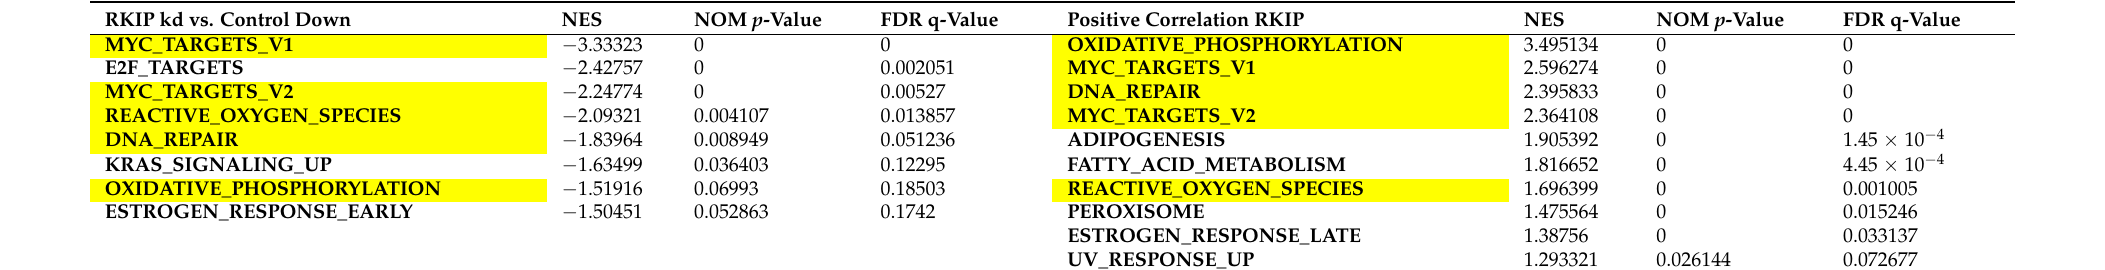
Table 2. GSEA kd down and positive correlation. The top hits are listed from the GSEA analysis of the RKIP knockdown (genes downregulated) and those that are positively correlated with RKIP expression in the breast cancer TCGA samples. All eight gene sets with q values less than 0.2 are listed. The top 10 ranked by NES of the sets positively correlated with RKIP expression are listed. The gene signatures shared between the two groups are highlighted. NES, Normalized Enrichment